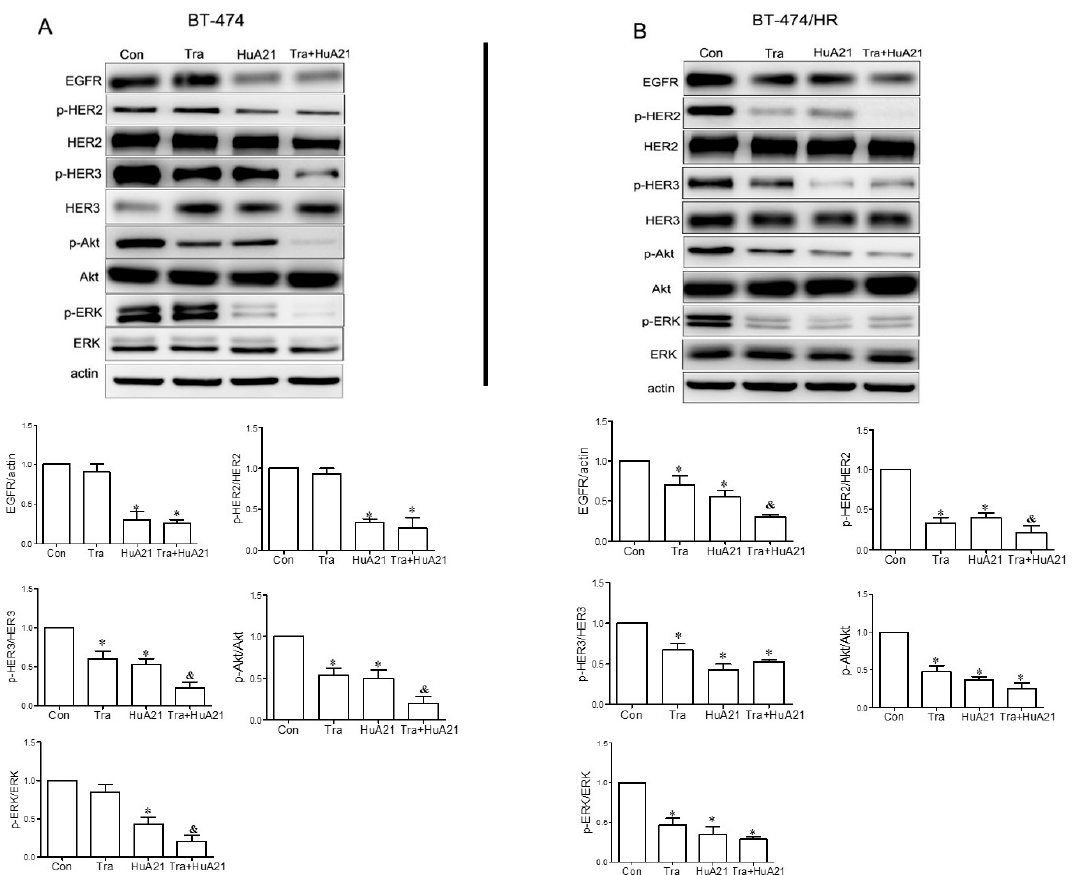
Figure 4. HuA21 inhibited HER2 receptor-related signaling pathways. A Western blot and the representative picture showing the bands of EGFR, p-HER2, total HER2, total HER3, p-Akt, total Akt, p-Erk1/2, and total Erk1/2 expressed in the BT-474 ( A ) and BT-474/HR cells ( B ) treated with HuA21, trastuzumab (Tra), or HuA21 + Tra. β -Actin was used as the loading control. * p < 0.05 vs. control; & p < 0.05 vs. HuA21-treated cells. The experiments were performed in triplicate, and the data are representative of three separate experiments.